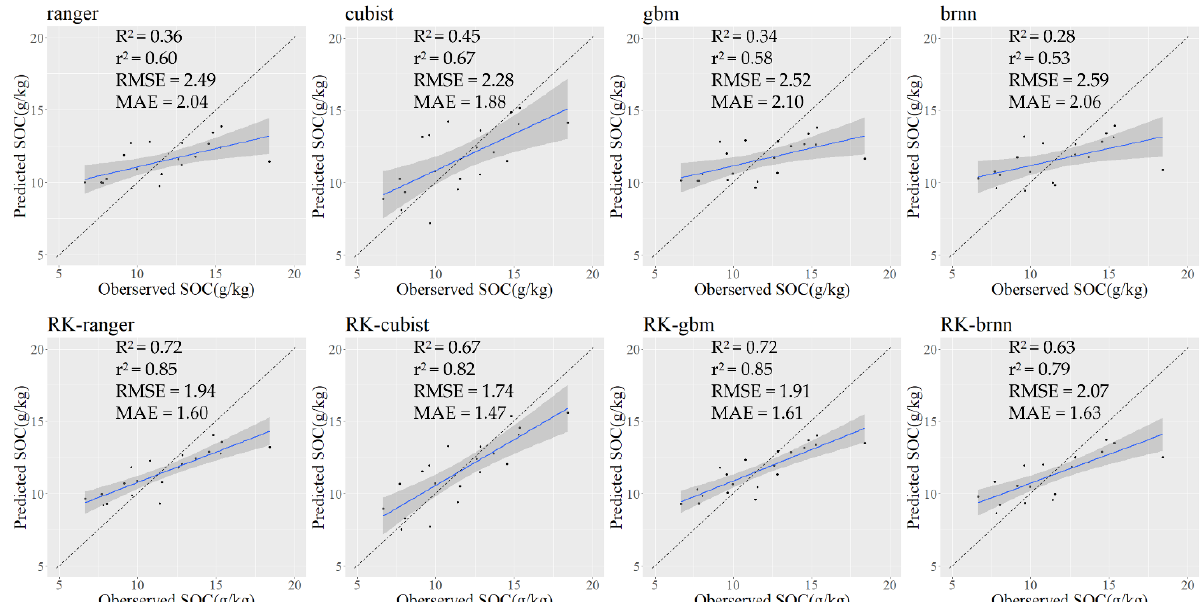
Figure 6. Predicted – observed fitted line of the ML models and RK models. Notes: The shaded area indicates the confidence interval of the fitted line at the 95-percent confidence level. The r 2 evaluates the deviation from the 1:1 line, whereas the R 2 evaluates the deviation from the fitted linear regression line between measured and predicted values.